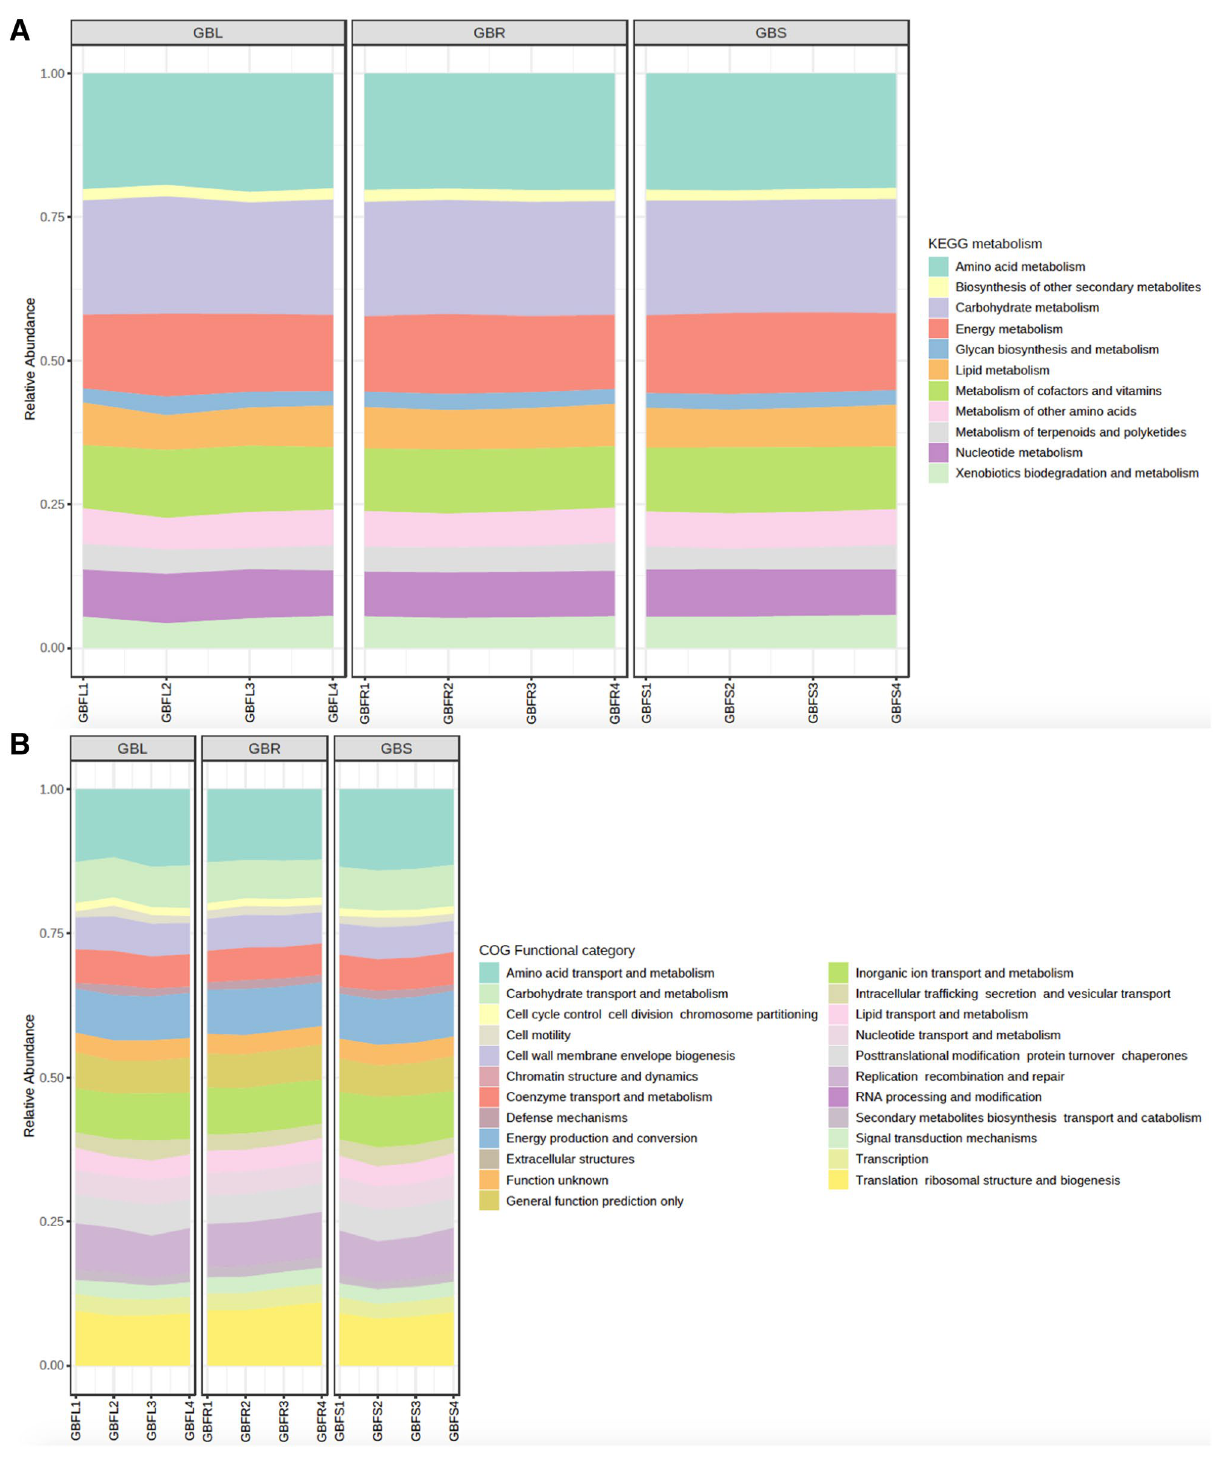
Figure 9. Prediction of functional pathways of Ginkgo biloba associated bacterial communities. ( A ) Kyoto Encyclopedia of Genes and Genomes (KEGG) metabolism and ( B ) Clusters of Orthologous Groups of proteins (COG) functional